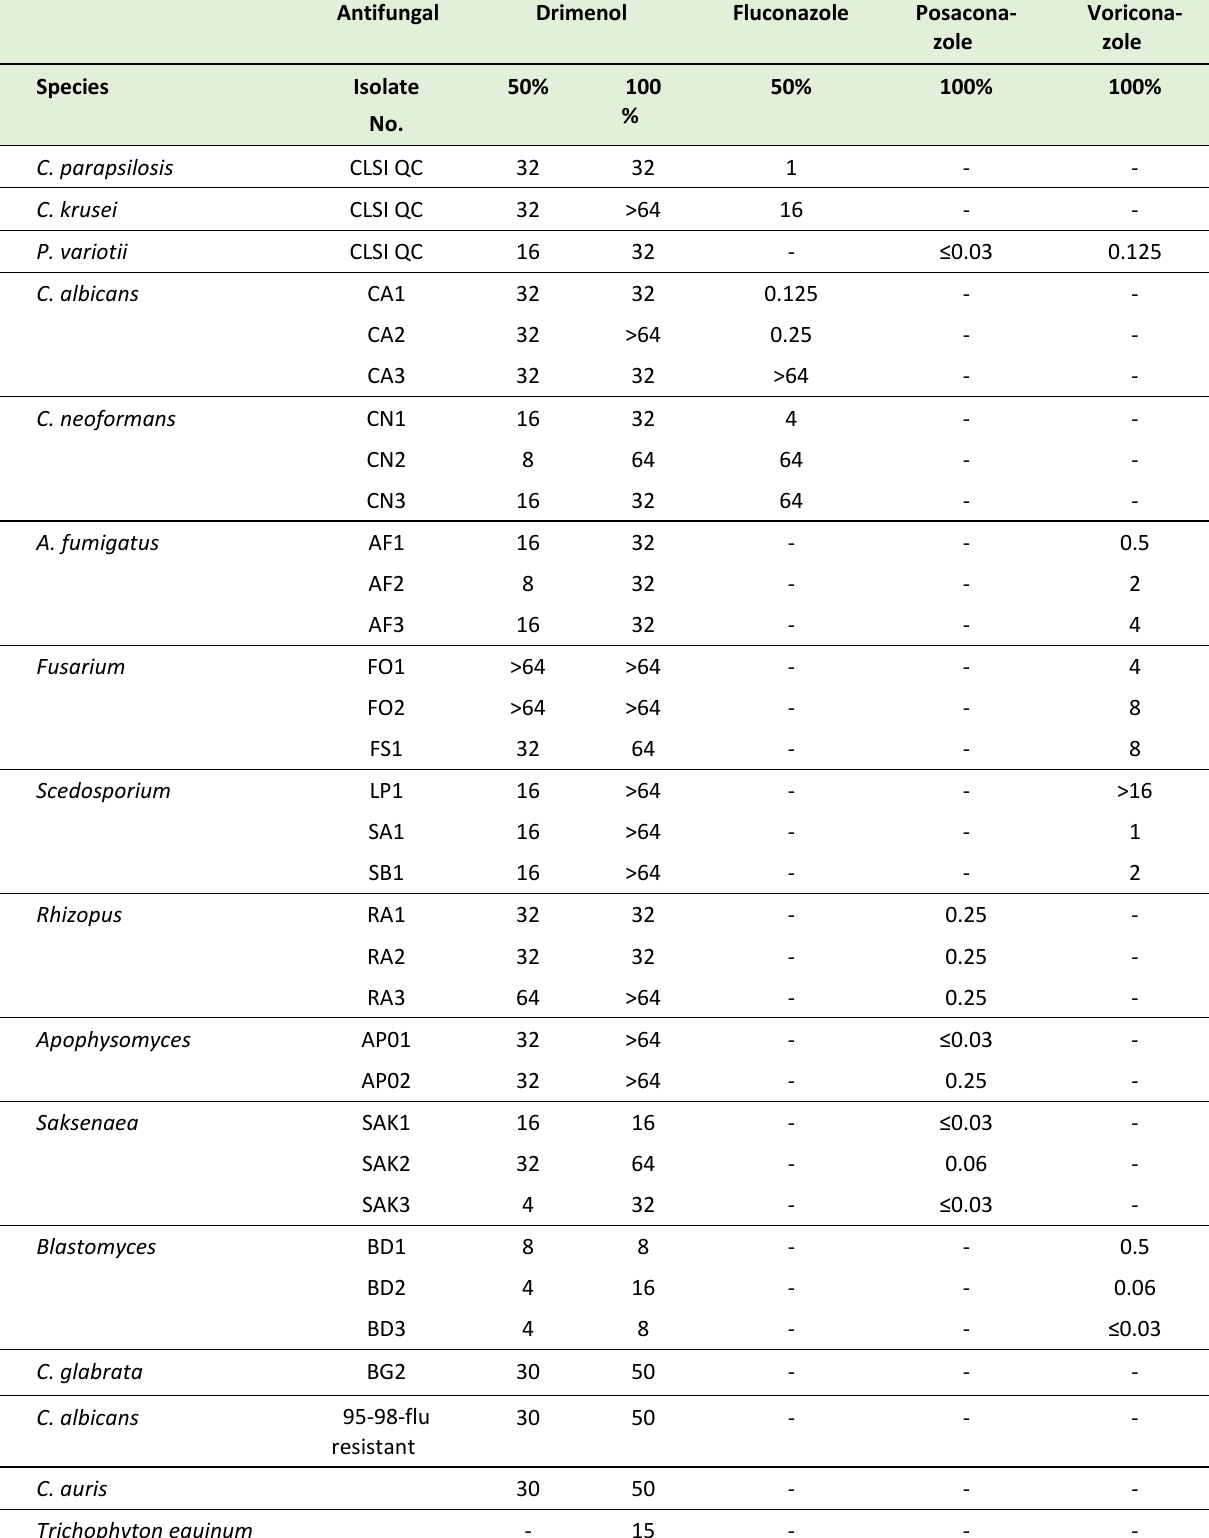
TABLE 2. Drimenol (1) activities (in µg/ml) against various pathogenic